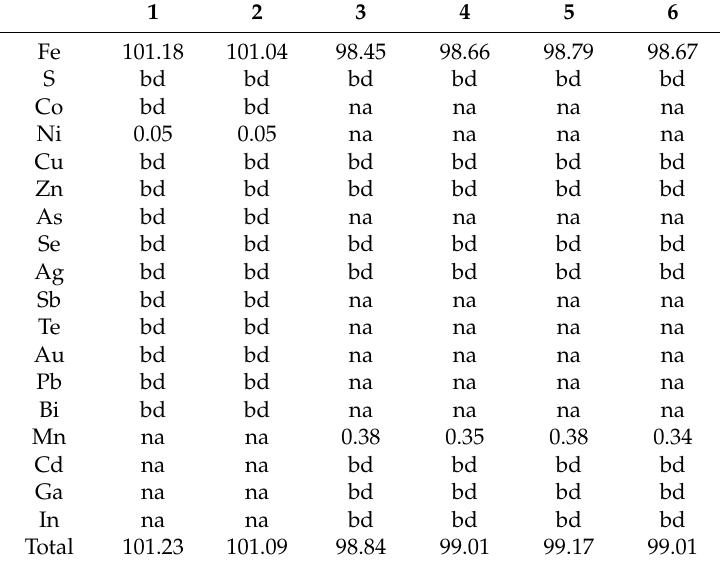
Table 1. Representative EMP compositions of native iron (in element wt.%).